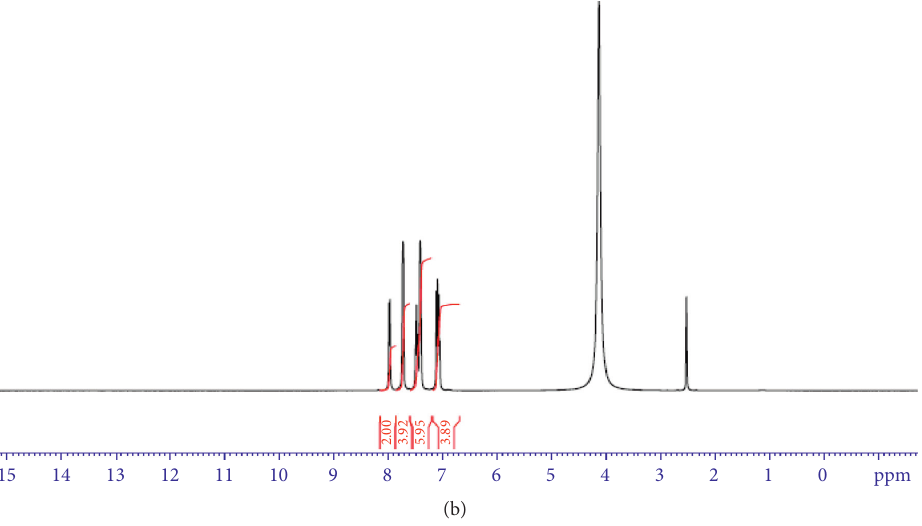
Figure 5: 1 H-NMR spectra of Al 3+ complex. (a) DMSO. (b) D